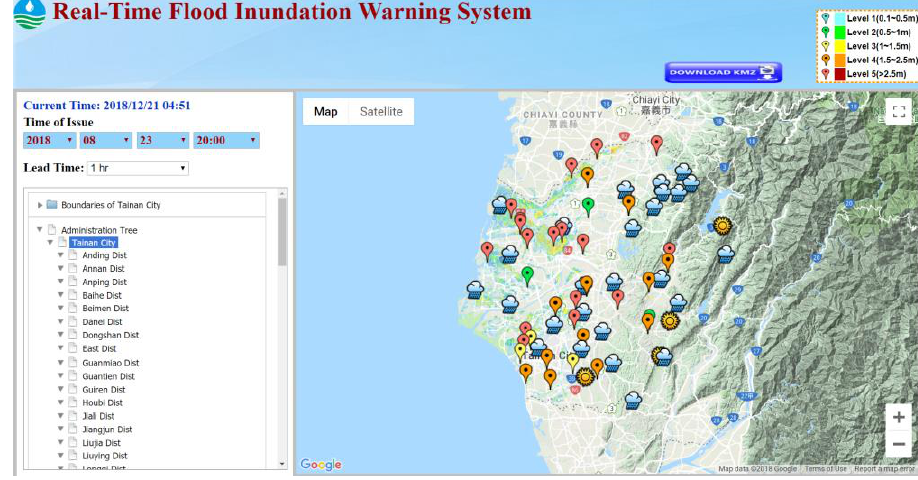
Figure 3. A web frame of the real-time flood warning system for Tainan City.